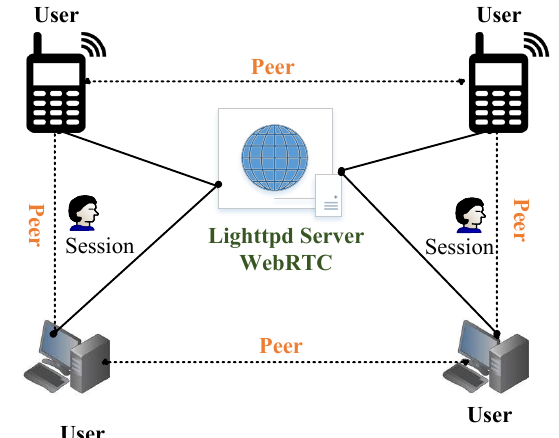
Figure 7. A generic overview for the integration of WebRTC in